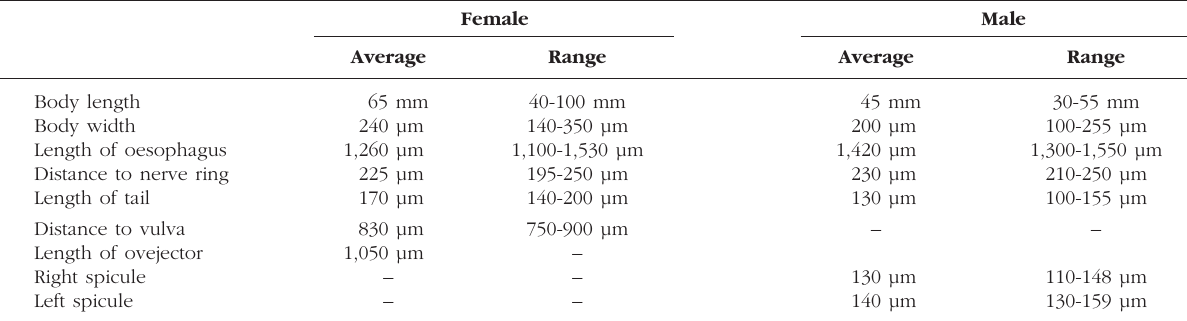
Table I. – Morphometrics of female and male worms (four complete females, three complete males and several long anterior and poste- rior parts of females and males) of Rumenfilaria andersoni from the reindeer in